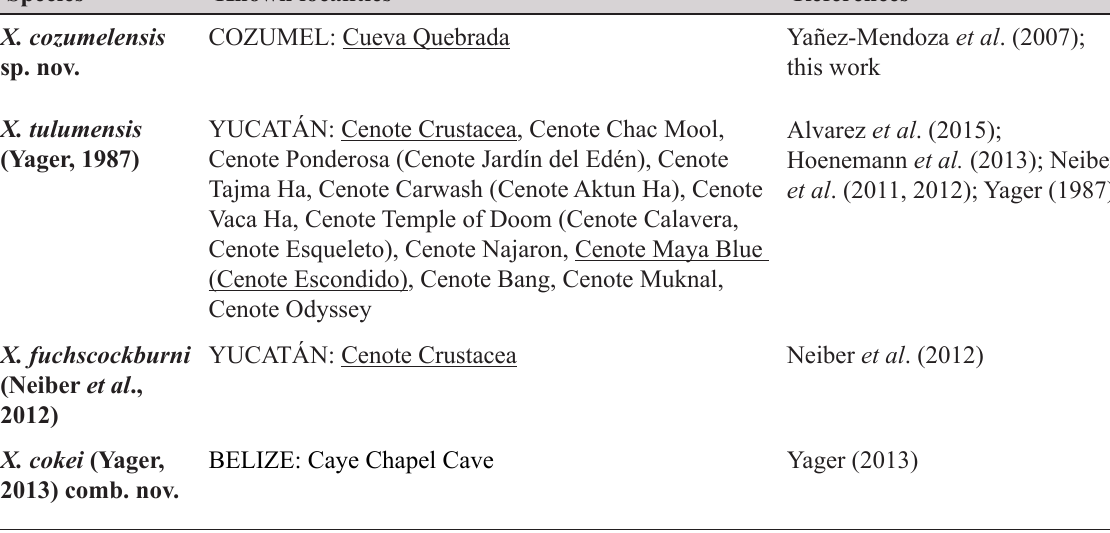
Table 4. Localities of Xibalbanus on the Yucatán Peninsula, including Belize and Cozumel reported in literature or observed by T.M. Iliffe. Several other sites from mainland Yucatán have been reported by non-biologist cave divers, but as stygiomysids can easily be mistaken for remipedes in the field, only published reports or personal observations have been included in the table. The localities from which CO1 and/or 16S has been sequenced and used/reused in this work are underlined (see listed references for more